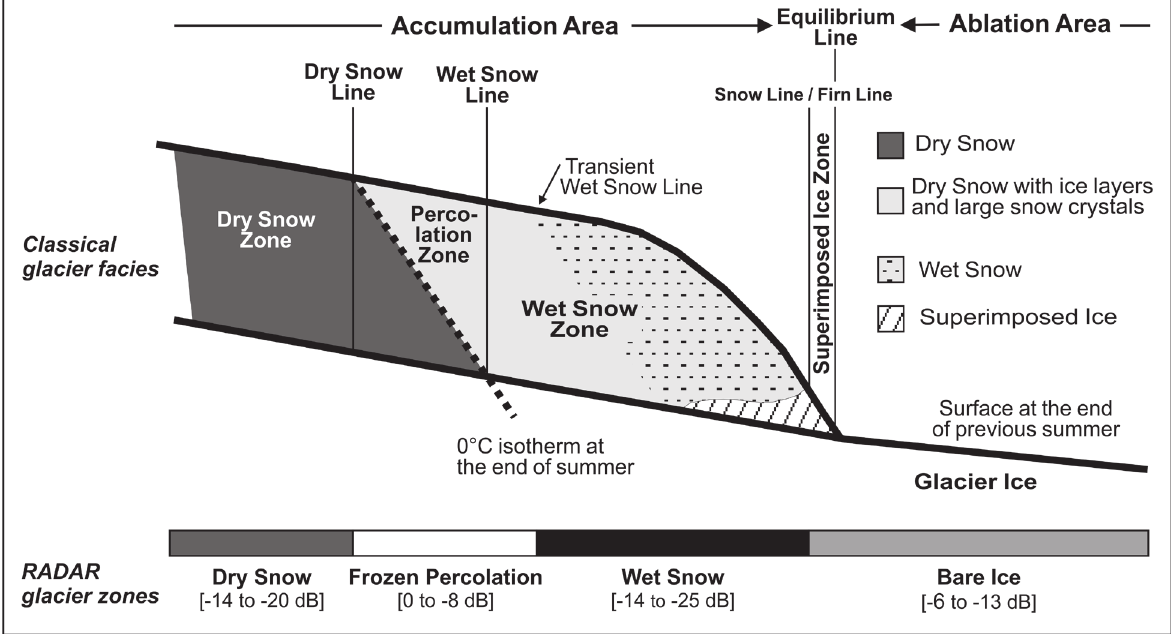
Figure 1. Classical glacier facies as described by Paterson (1994) and corresponding RADAR glacier zones as detected by SAR sensor. Modified after Rau et al.